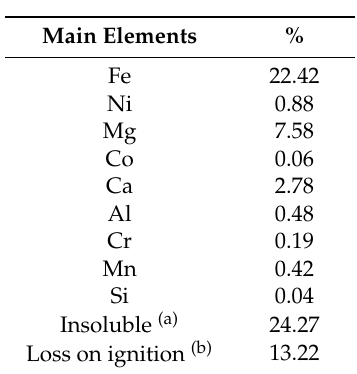
Table 1. Chemical analysis of ore sample.